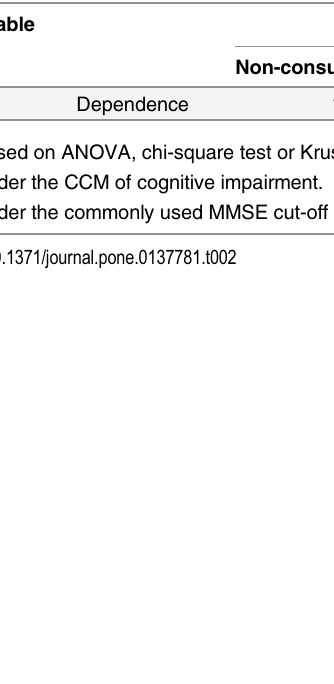
Table 3. Logistic regression models fitting results of the association between tea consumption volume and cognitive impairment 1 . Tea consumption volume P 2 Non-consumption (n = 6845) < 2 cups/d (n = 546) 2 – 4 cups/d (n = 1011) (cid:1) 4 cups/d (n =